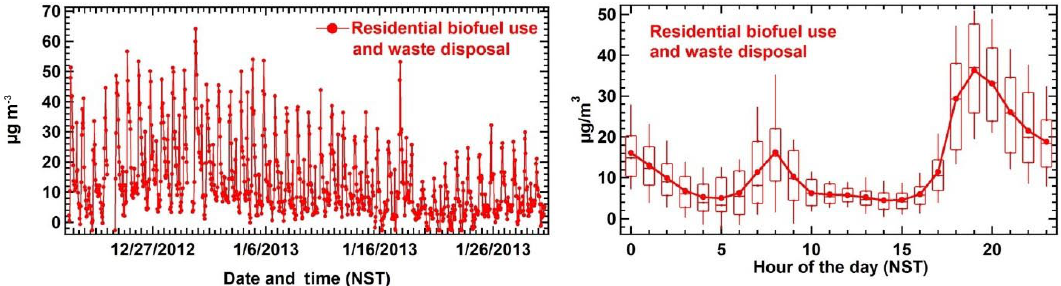
Figure 5. Time series and diel box and whisker plot for Factor 2 (residential biofuel use and waste disposal).